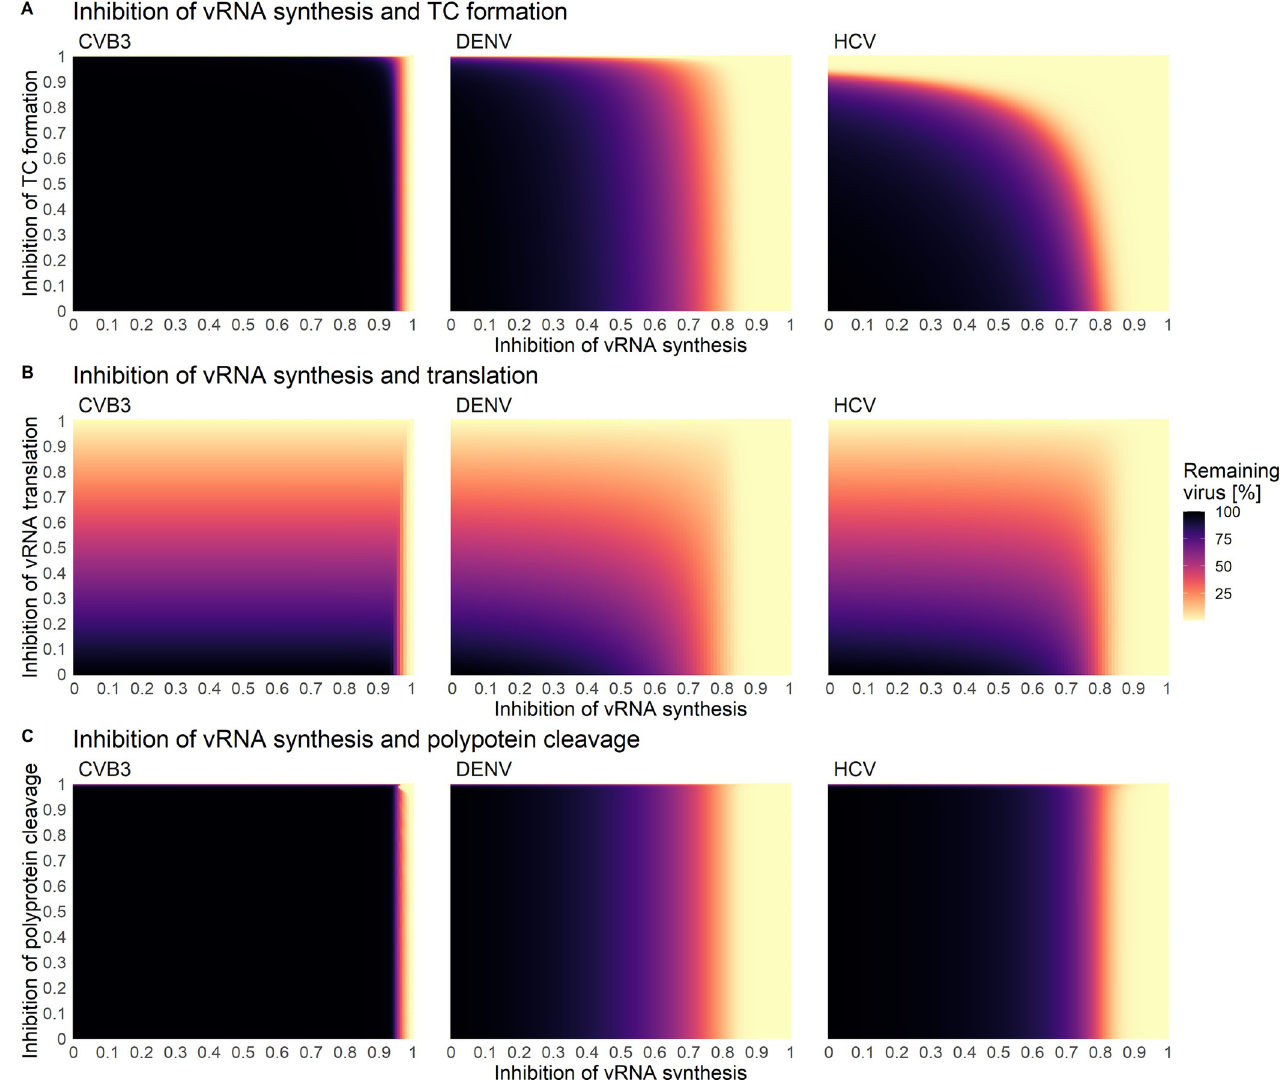
Fig 8. Combined drug effect on A) vRNA synthesis and formation of translation complex (TC), B) vRNA synthesis and translation, and C) viral RNA synthesis and polyprotein cleavage. Initiation of treatment was in steady state (100 h pi). A successful drug treatment leads to more than 99% viral eradication (light yellow), while an ineffective drug treatment leads to 100% remaining virus